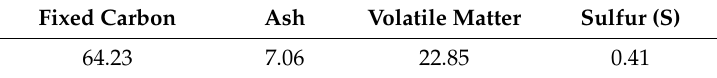
Table 2. Proximate analysis of coal (wt